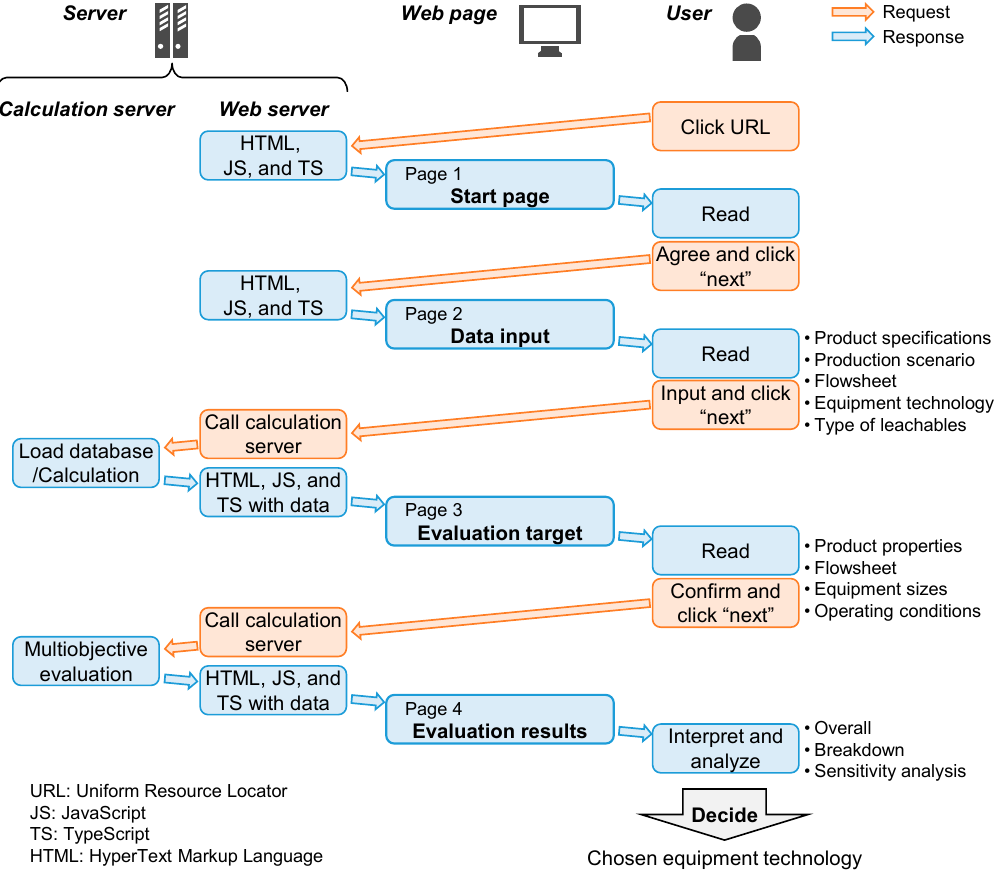
Figure 5. Architecture of “ TECH oice” with flows of requests and responses over four web pages. Table 3. Possible range of input parameters.